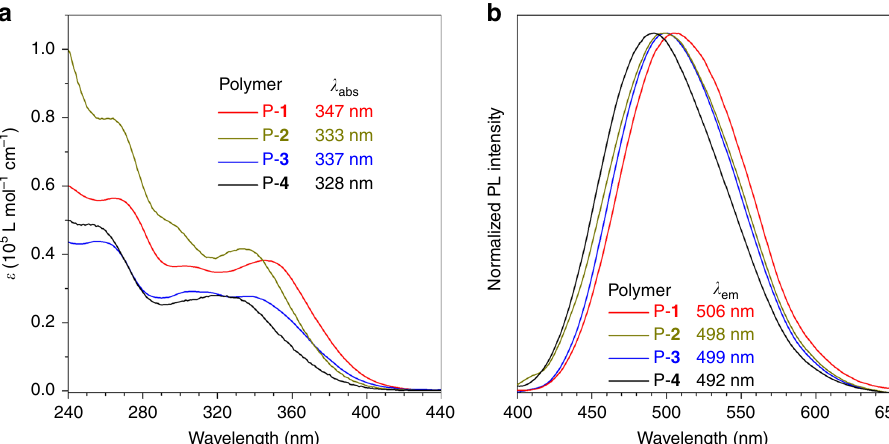
Fig. 7 Photophysical properties of these four polymers. a Ultraviolet absorption spectra of P- 1 , P- 2 , P- 3 , and P- 4 in THF. b Normalized photoluminescence (PL) spectra of P- 1 , P- 2 , P- 3 , and P- 4 in THF/water mixture (v/v, 7:3). Concentration: 10 − 5 M. λ ex (nm): 355 (P- 1 ), 345 (P- 2 ), 345 (P- 3 ), and 340 (P- 4 ). λ = absorption maximum, λ = emission maximum abs em